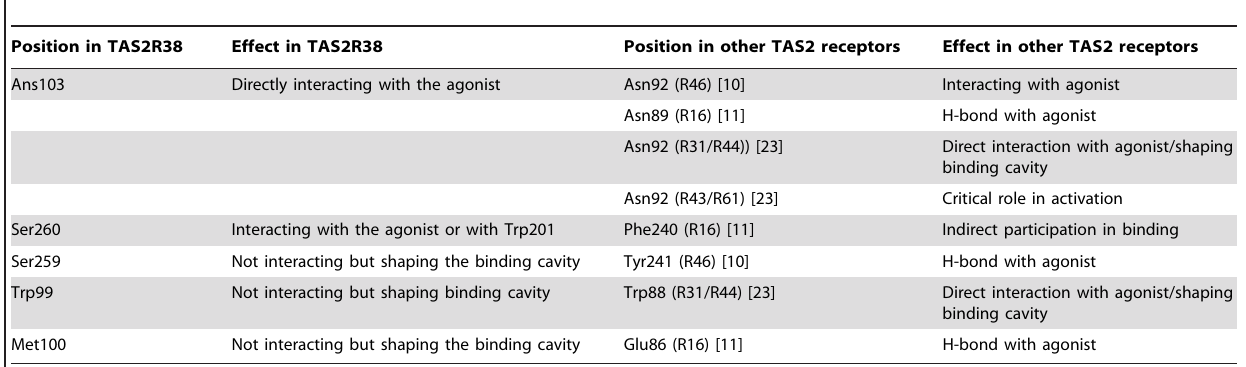
Table 3. Analysis of the positions mutated in this work that were also mutated in other members of the bitter receptors family.